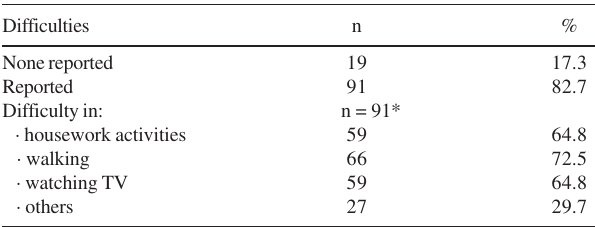
Table 1 - Daily difficulties as a result of cataracts